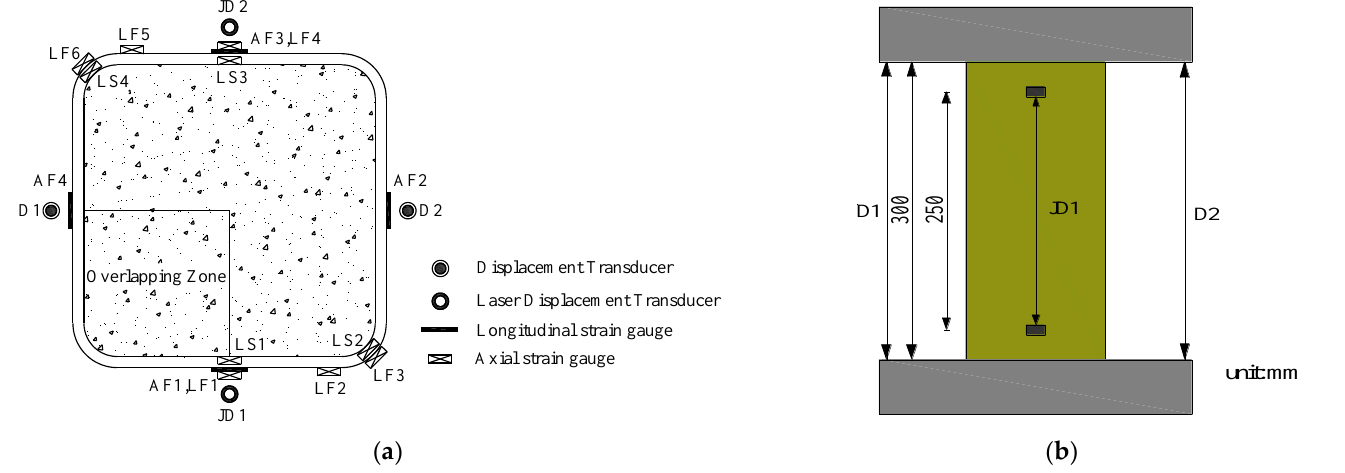
Figure 4. Instrumentation configuration and test setup: ( a ) layout of strain gauge and displacement transducer; ( b ) test setup.